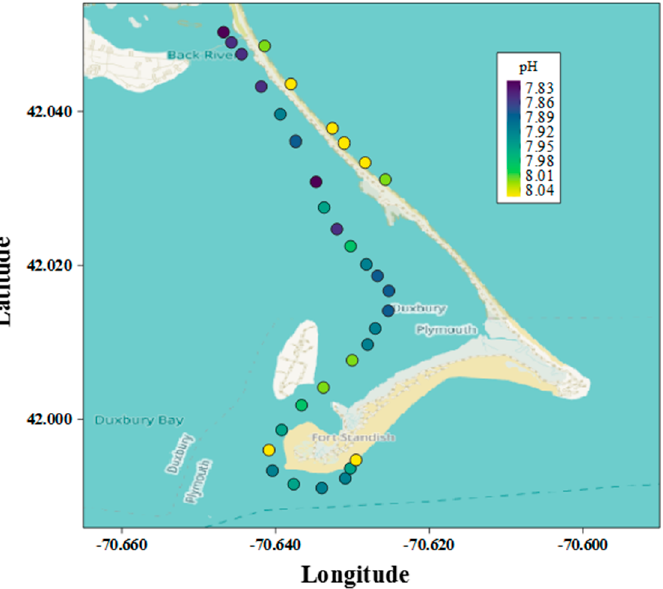
Figure 5. (pHyter pH measurements from a kayak). In situ surface water pH measurements made by the pHyter in Duxbury Bay, MA, are shown as circles at the measurement location. The circles are colored based on the pH measured (color scale in upper right corner). The pHyter was operated from a kayak over ~4 h.